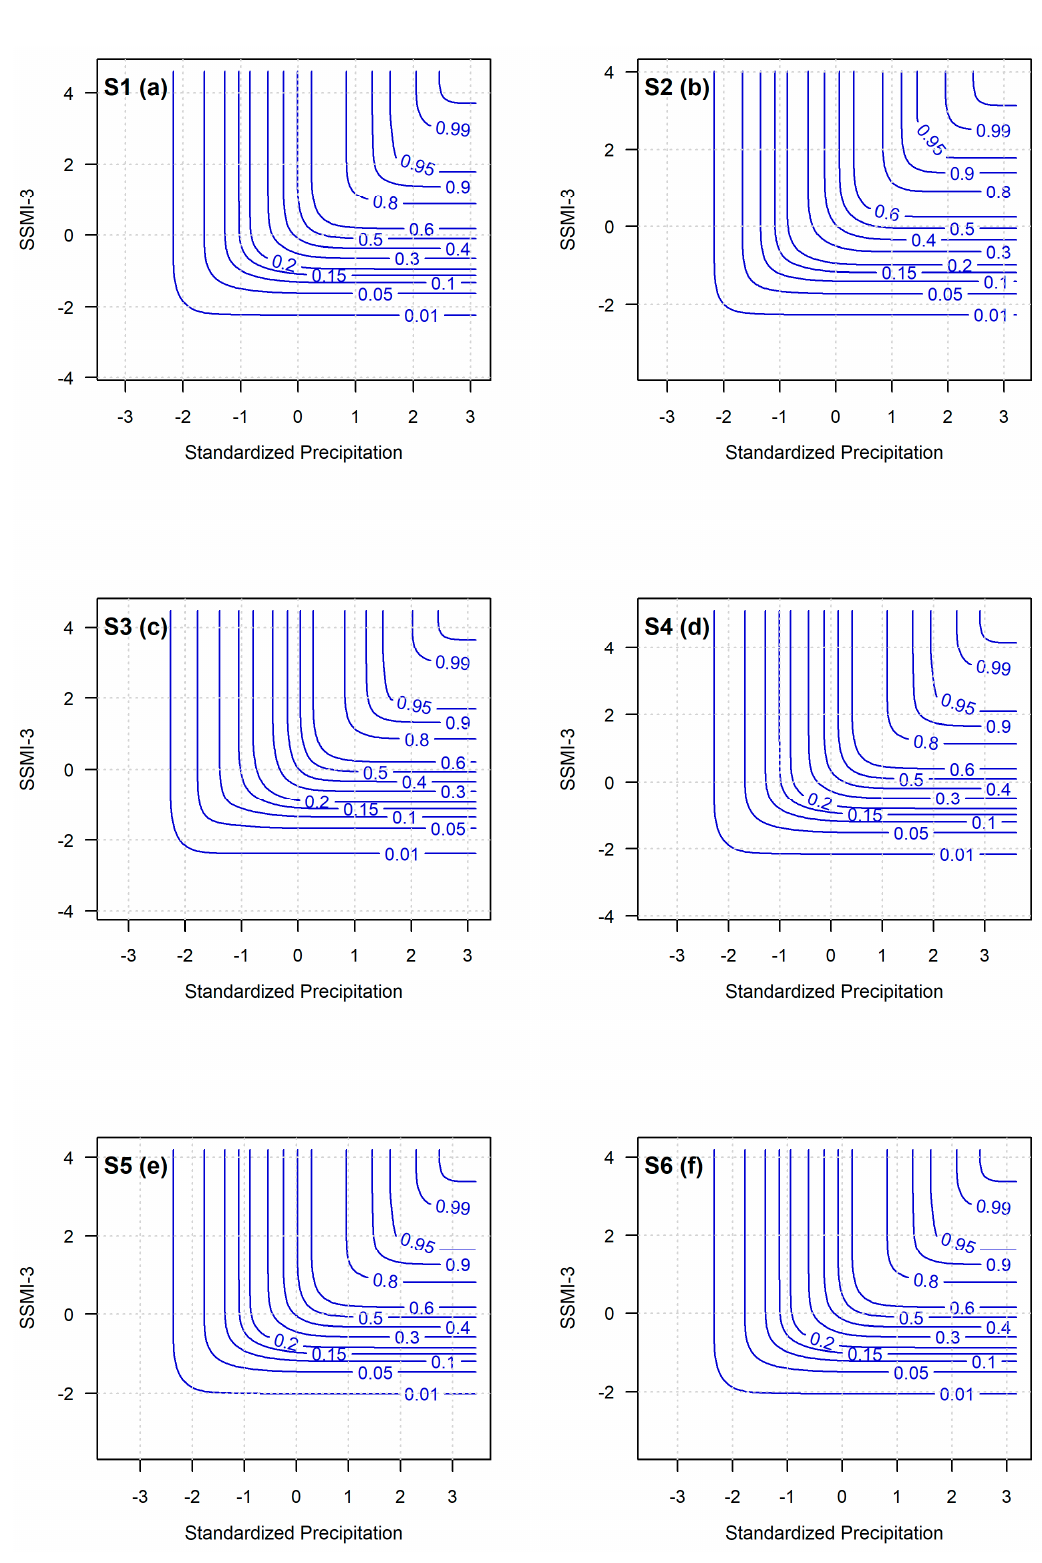
Figure 4. Bivariate relationship between SSMI3-P using KDE for summer months ( a – f ).